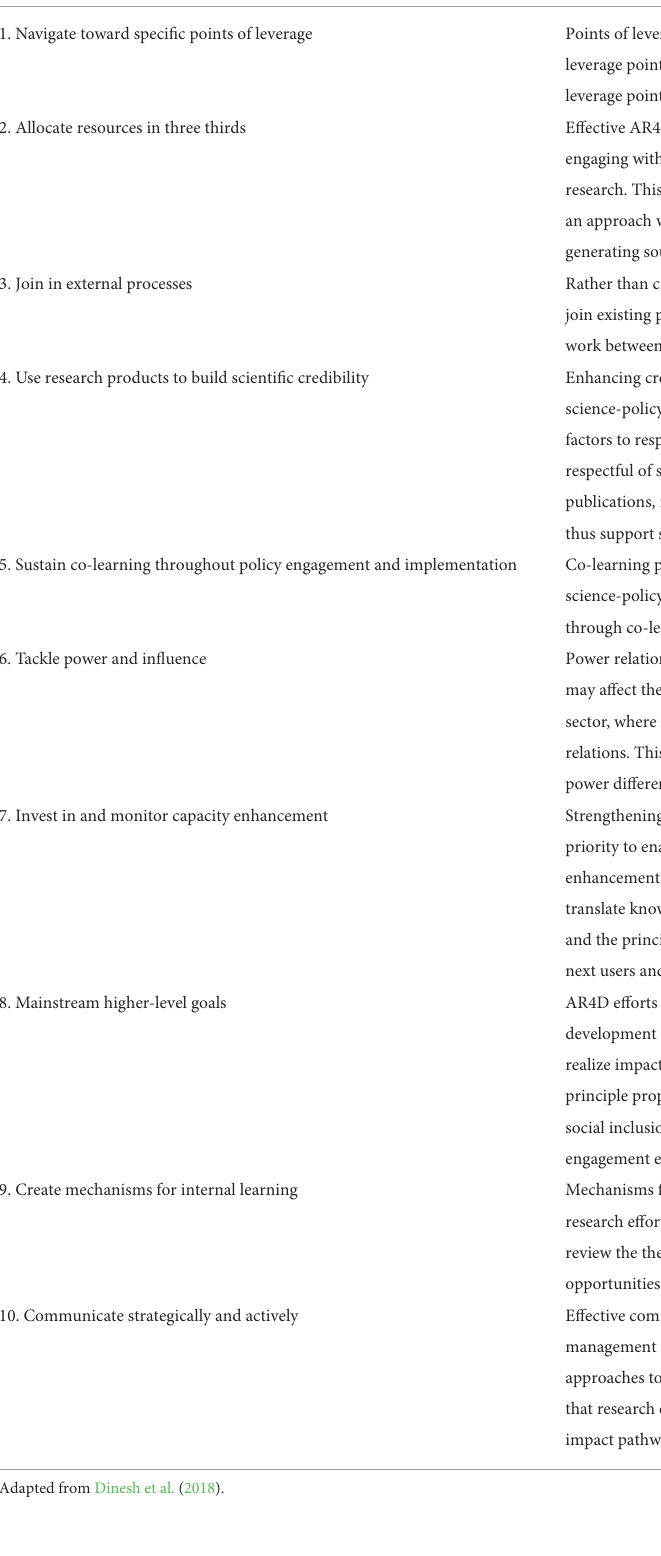
TABLE 1 CCAFS principles for agricultural research and